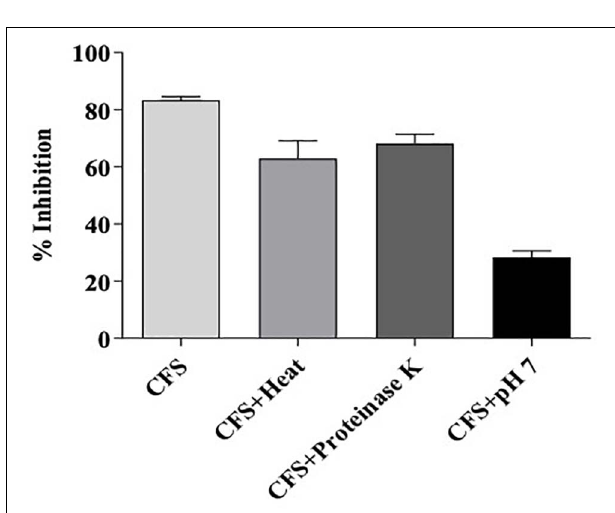
FIGURE 9 | Residual bioactivity of L. brevis MYSN105-CFS against F. verticillioides after treatment with heat, proteinase K, or pH neutralization. Data shown are mean ± SE of triplicate values of three independent experiments.